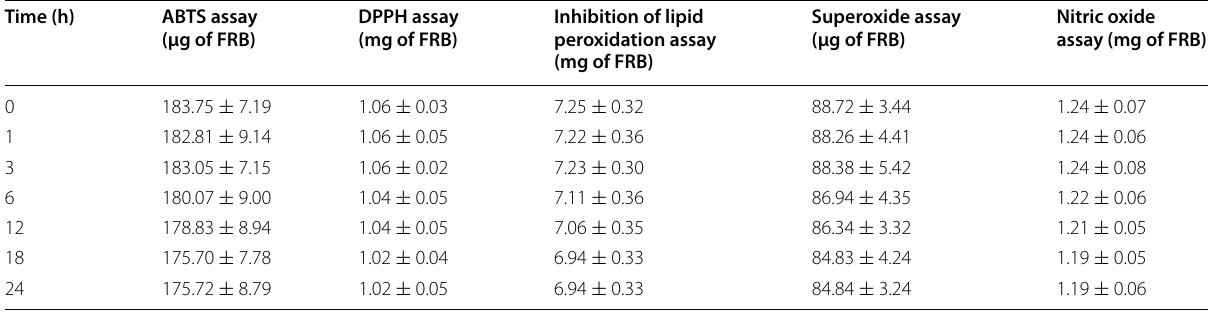
The values are IC 50 concentrations of FRB in the respective analysis Significant difference was not observed between the IC 50 values of fermented black rice bran in the respective free radical scavenging assay (ABTS or DPPH or lipid peroxidation or superoxide or nitric oxide inhibition assay) at 24 h of fermentation and IC 50 values of fermented black rice bran in the respective free radical scavenging assay at 0 h of